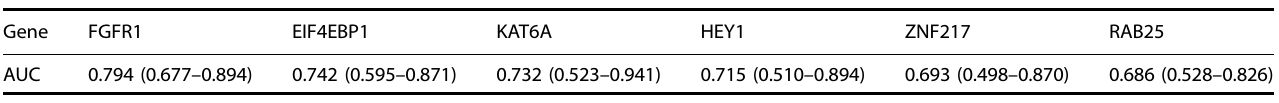
Table 4. AUC (with 95% CI) achieved by the models trained on the copy number alteration (CNA) data of breast cancer. Gene FGFR1